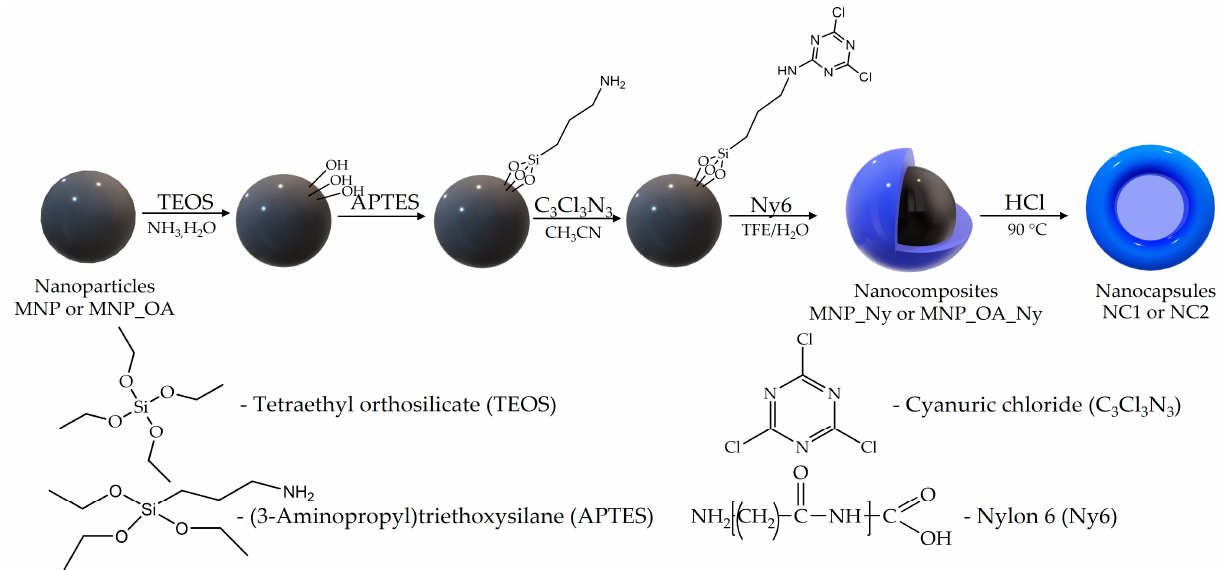
Figure 2. Schematic representation of magnetic nanocomposites’ and nanocapsules’ synthesis via widely used TEOS/APTES approach. TTE—trifluoroethanol.